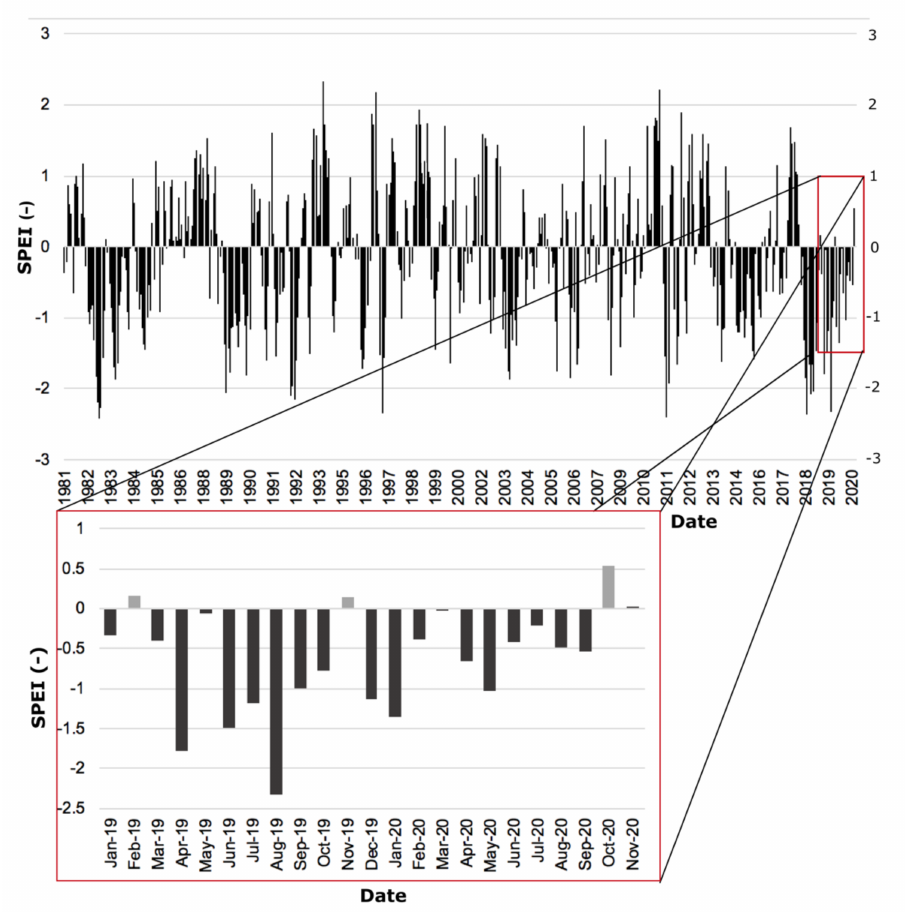
Figure 5. SPEI (standardized precipitation evapotranspiration index) values estimated over a three month scale during the period of 1981–2020 ( upper panel ), and for individual months during 2019–2020 ( bottom panel ). Reference period: 1950–2020, based on SPEI Global Drought Monitor database